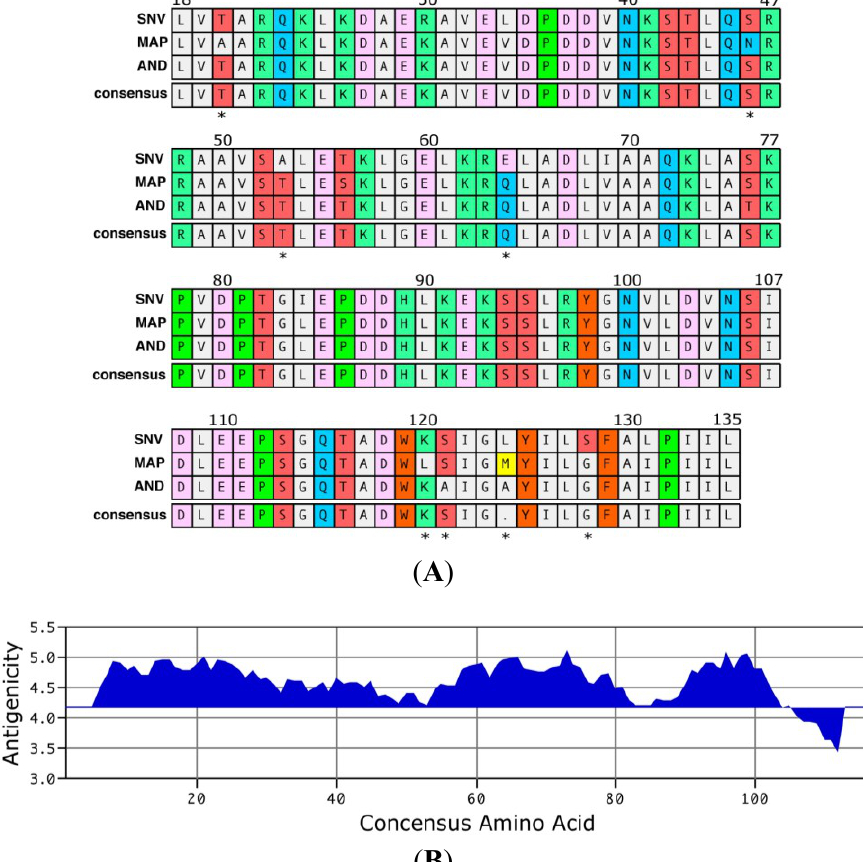
Figure 2. Alignment ( A ) and antigenicity ( B ) plot of the truncated nucleocapsid antigen. The 118 residue truncated Sin Nombre virus (SNV) polypeptide (15 kD) represents about 30% of the full-length nucleocapsid and is missing the N-terminal 13 amino acids and the C-terminus. The sequence was aligned to the homologous sequences of Andes and Maporal viruses using the CLUSTALW algorithm of MacVector software. Amino acid similarities are denoted by block color. The numbers above the sequences indicate the amino acid position within the full-length nucleocapsid protein. The asterisk (*) below the consensus indicates a dissimilar residue; the overall similarity is 93% (110/118), with four of the 8 dissimilar residues found in the C-terminus region with a predicted low antigenicity index. Antigenicity prediction was performed with the protrusion index prediction algorithm of MacVector, which scores amino acids for their hydrophilic and hydrophobic characteristics and is weighted based upon those characteristics of neighboring residues. Regions of hydrophilicity (potential antibody epitopes) are positive values, while regions of hydrophobicity are negative